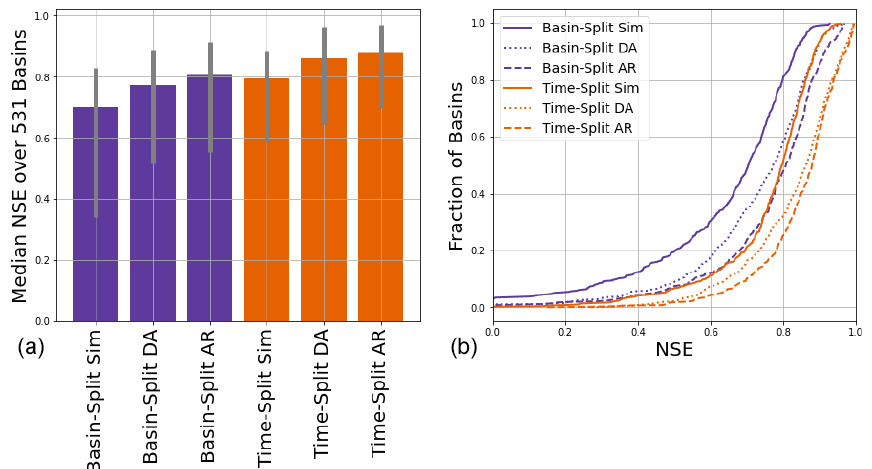
Figure 5. Comparison of NSE scores between time split and basin split models at 1d lead time with no training or inference (test) holdout. The left subplot shows median scores (over 531 basins) and 80% interval (10th to 90th percentiles), and the right subplot shows distributions (over 531